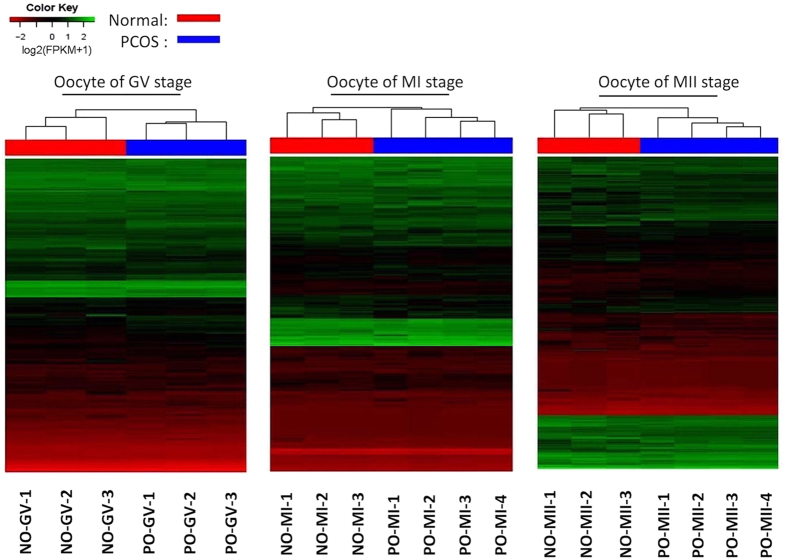
Heatmap of differentially expressed genes in oocytes with and without PCOS at GV, MI, MII stage.Green corresponds to up-expressed genes; red corresponds to down-expressed genes. NO-GV, oocyte at GV stage from normal women; PO-GV, oocyte at GV stage from women with PCOS; NO-MI, oocyte at MI stage from normal women; PO-MI, oocyte at MI stage from women with PCOS; NO-MII, oocyte at MII stage from normal women; PO-MII, oocyte at MII stage from women with PCOS.